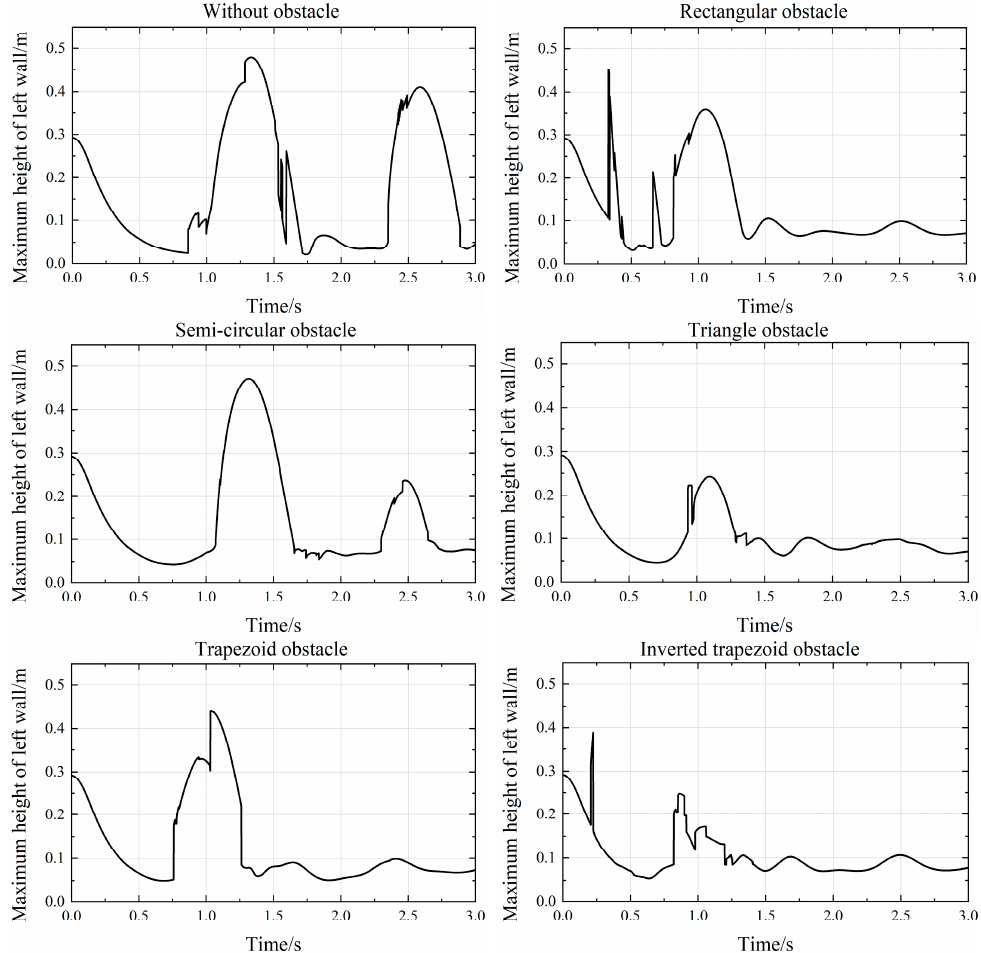
Figure 10. The maximum height of the water column on the left wall of the obstruction container of di ff erent shapes.